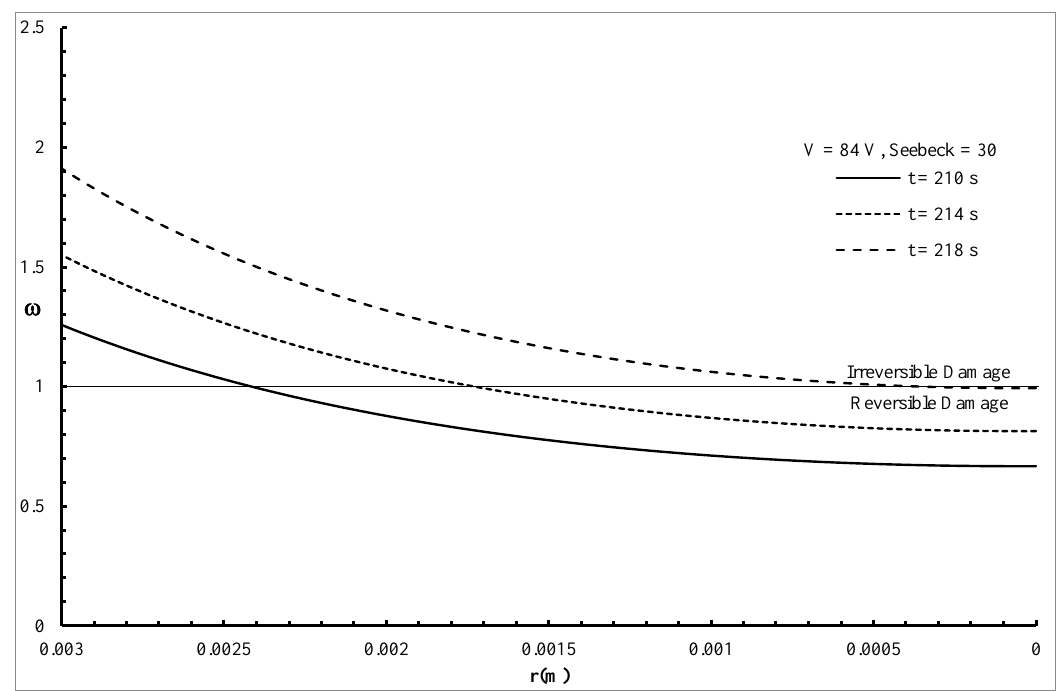
Figure 15 . The thermal damage distribution of liposarcoma tumor with various values of time when 600 R   . e